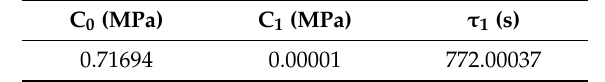
Figure 5. Results of the optimization with the experimental data: ( a ) bubble pressure vs bubble height and ( b ) bubble pressure vs times. Table 2. Materials constants for PMSQ–HDPE at 130 °C.